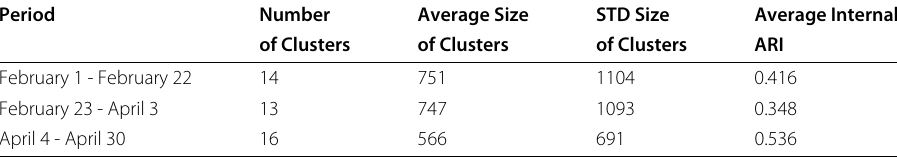
Period Number Average Size STD Size Average Internal of Clusters of Clusters of Clusters